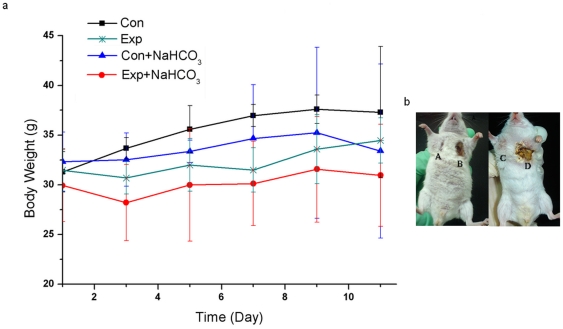
The side effects of Free Tet and Tet-NPs.a. The body weight change of the mice during therapy under different treatments. Body weight loss in this study is not an ideal parameter for the evaluation of wide effects in this study because every mouse received two different treatments. Nevertheless, the body weight of the Exp+NaHCO3 group was much lower than in the Con+NaHCO3 group while the differences of body weight between the Exp and Con group was not so obvious. b. Photos of the ulceration taken at the 7th day after administration. (A. Tet-NPs pH 6.8, B. Free Tet pH 6.8, C. Tet-NPs pH 7.4 and D. Free-Tet pH 7.4). Ulcerations were evaluated in details in Fig.S5.